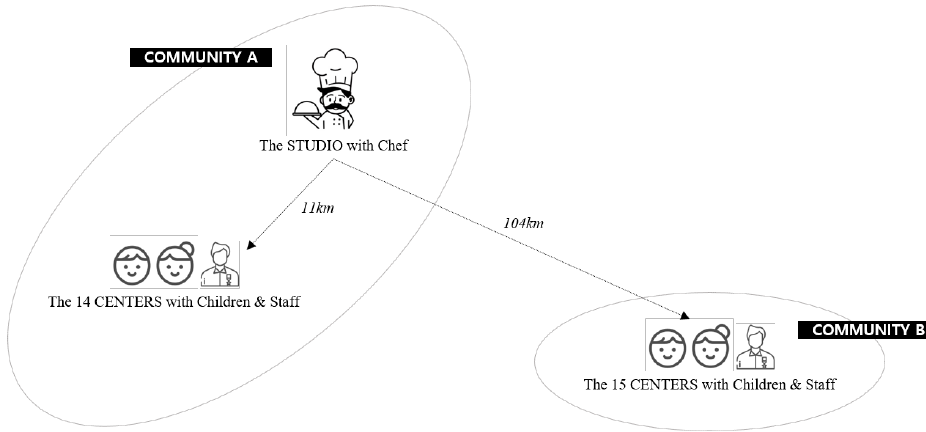
Figure 1. Location and setting for the interactive live and online cooking program.